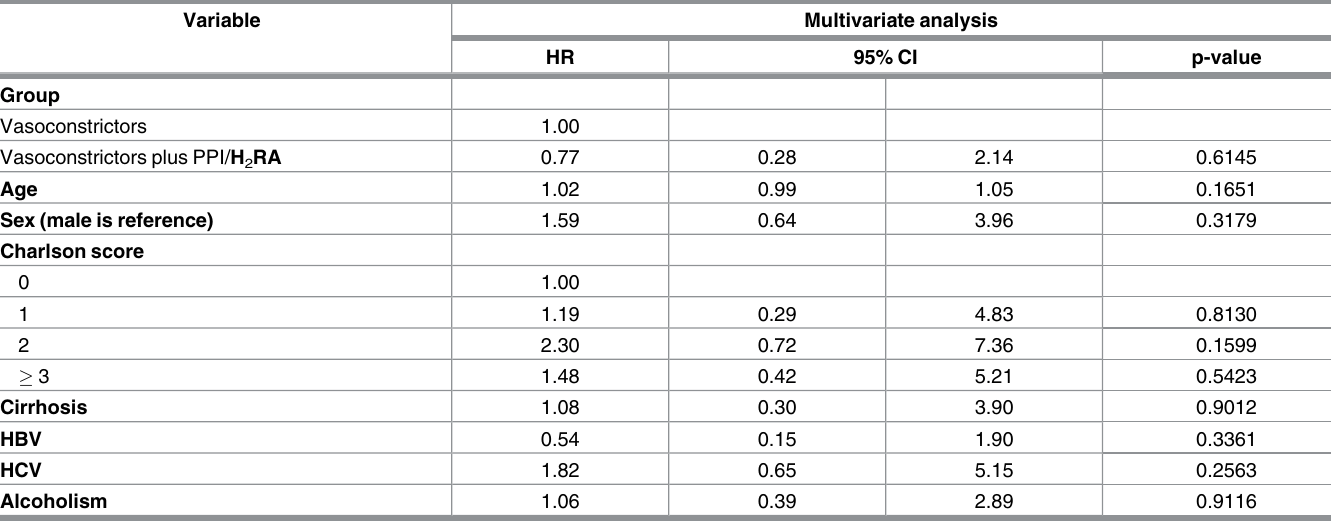
Table 4. Independent risk factors of rebleeding in all study populations during the 15-yearfollow-up period.